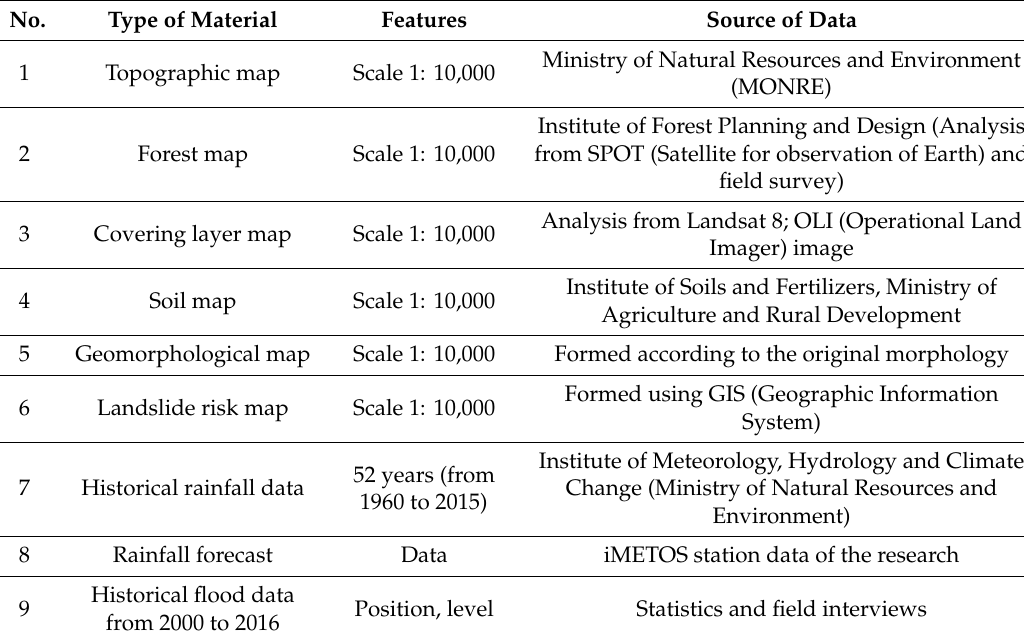
Table 1. Materials used in the